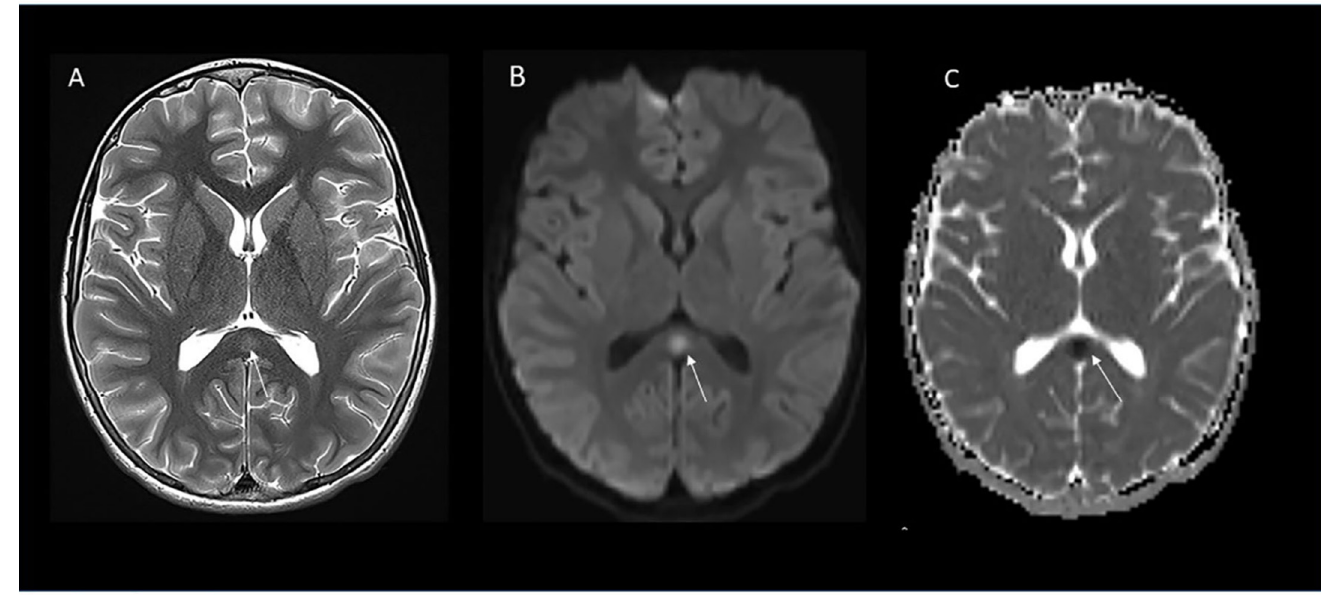
Figure 1. Timeline of development of MIS-C-like symptoms after Lyme disease and COVID-19 mRNA vaccination. Abbreviations: EM, erythema migrans; PICU, pediatric intensive care unit; PTA, prior to admission.